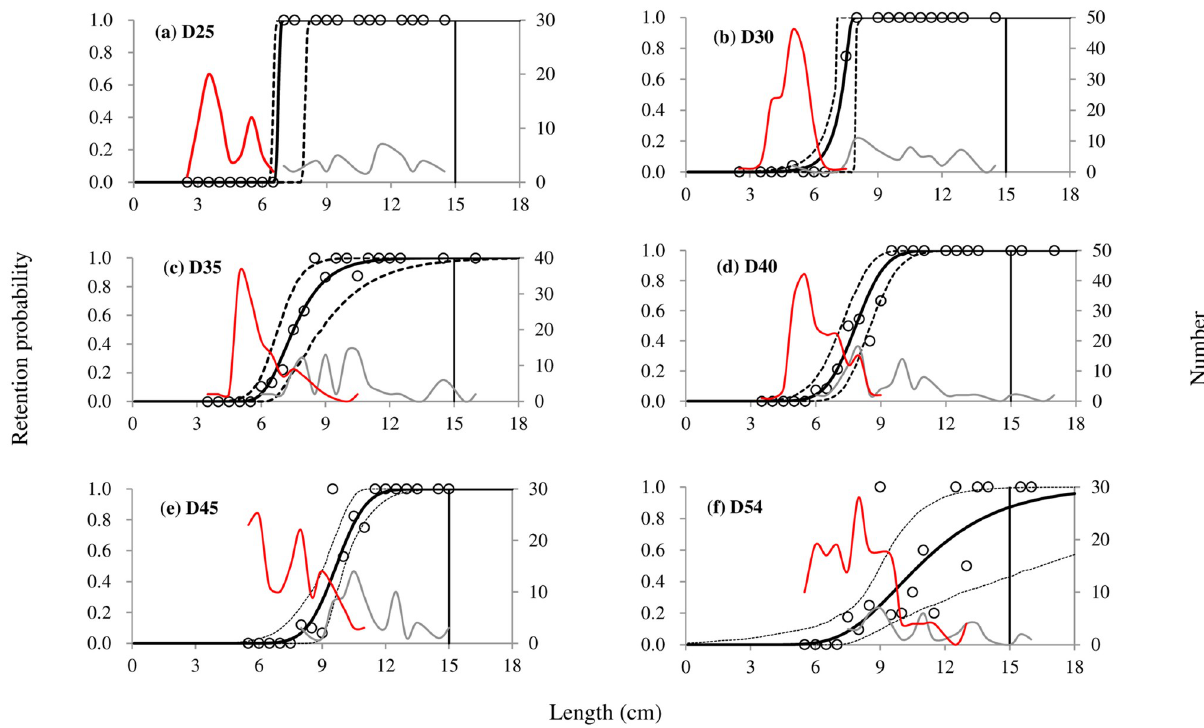
Fig 3. Experimental catch proportion and selectivity curves. Circle marks represent experimental catch proportion. Red curves represent the size distribution of fish caught by the cover, grey curves represent the one caught by the tested codend. Stippled curves describe the 95% confidence intervals for the fitted selection curves. Vertical lines represent the MLS (minimum landing size).